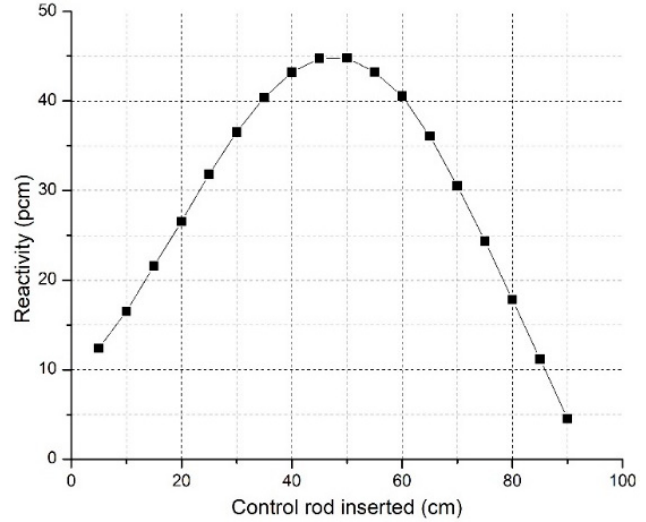
Figure 12. Differential control rod worth of secondary control assemblies at BOC. Figure 12. Di ff erential control rod worth of secondary control assemblies at